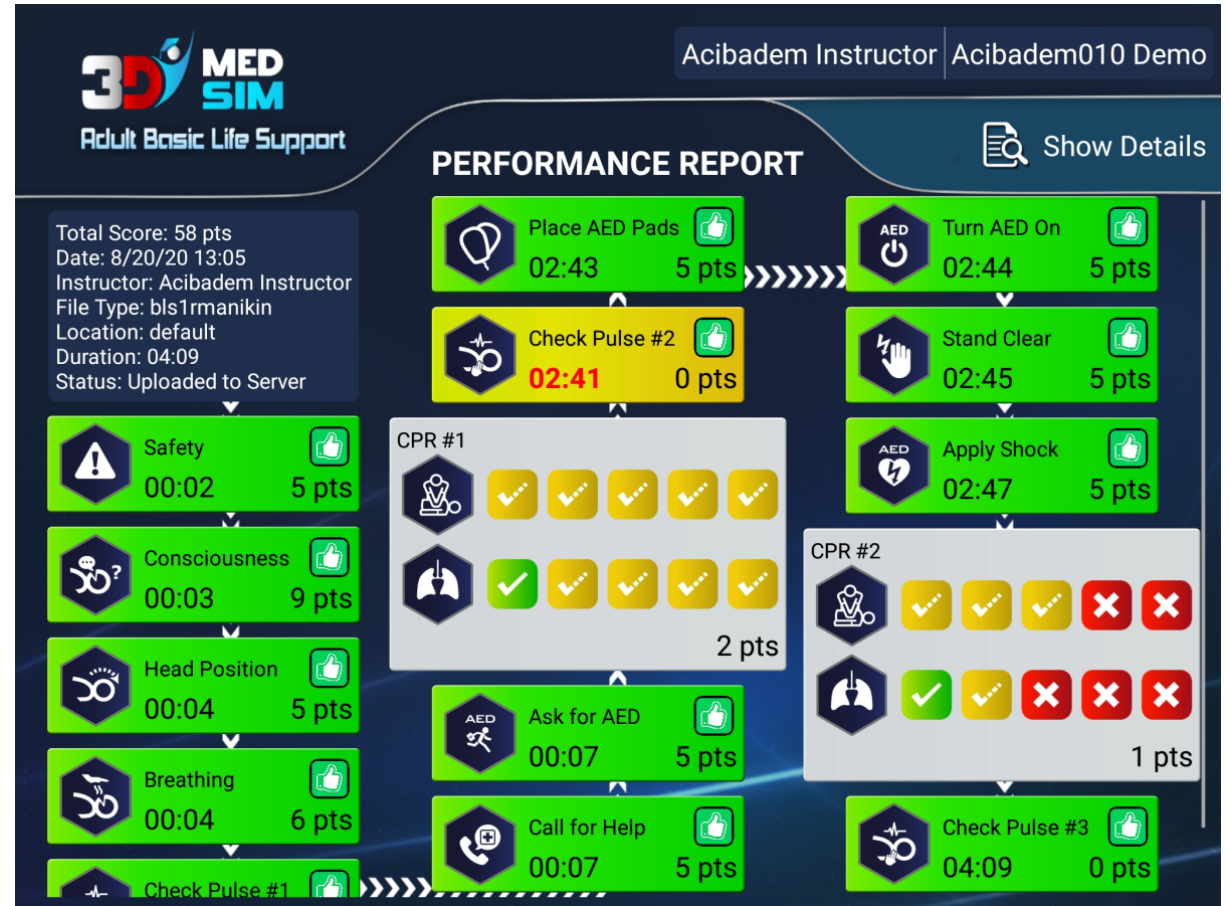
Figure 7. Performance report screen hands-on